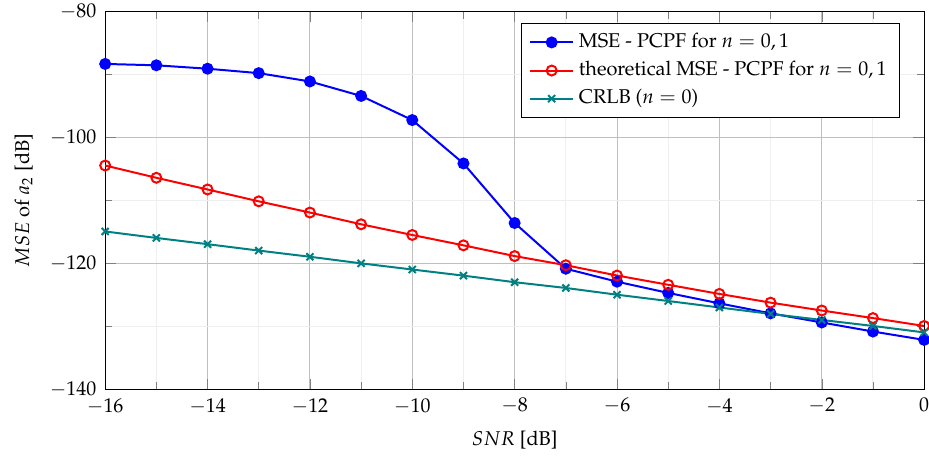
0,1 . 0,1 . Figure 13. Theoretical and measured MSEs of the PCPF for n = { } { }